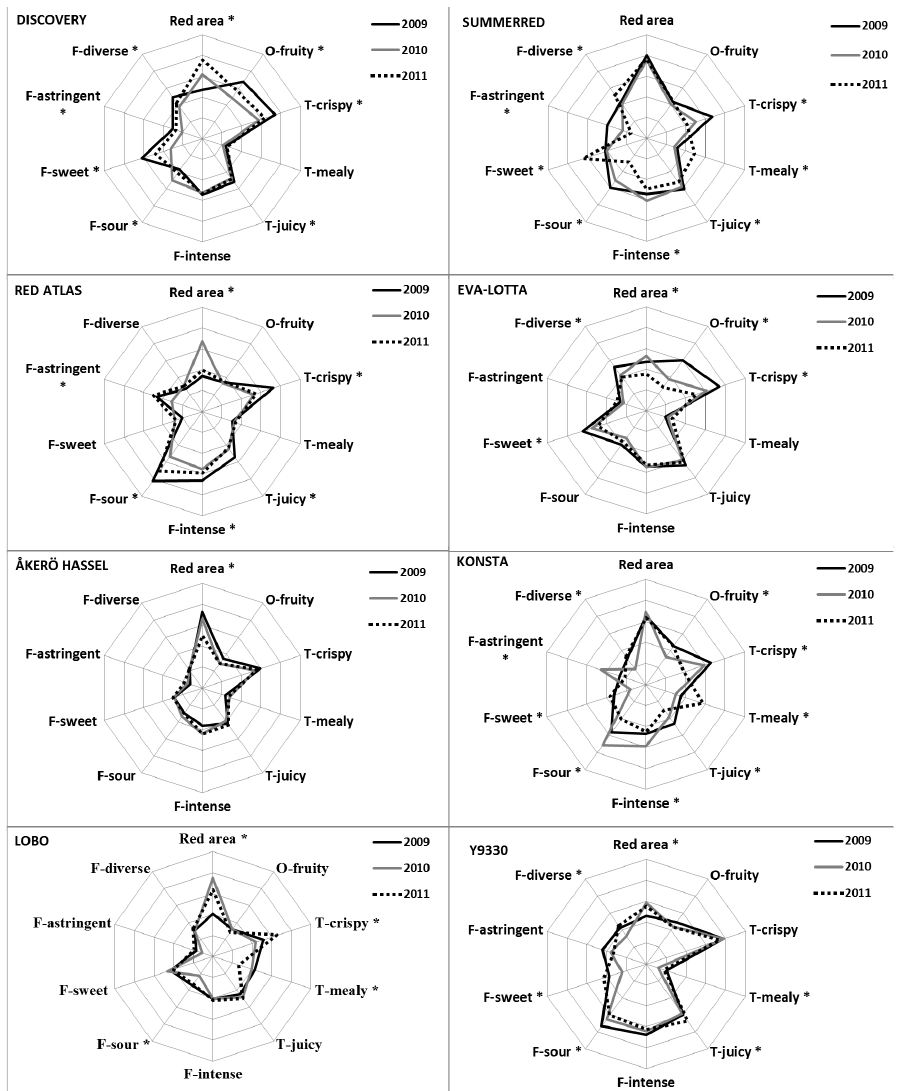
Fig. 3. Profiles of eight autumn and winter cultivars over three harvest years 2009, 2010 and 2011. Prefix O, T or F before an attribute name denote texture, odour and flavour, respectively;* p <